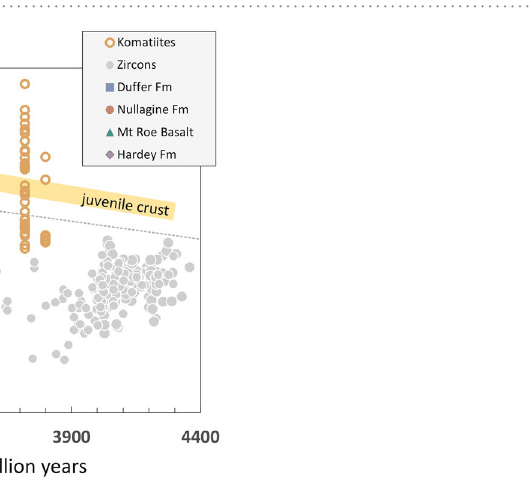
Figure 1. Relationship between ε Hf and Al/K (as an index for weathering) of black shale samples shows no correlation. Colours as in Fig. 2.